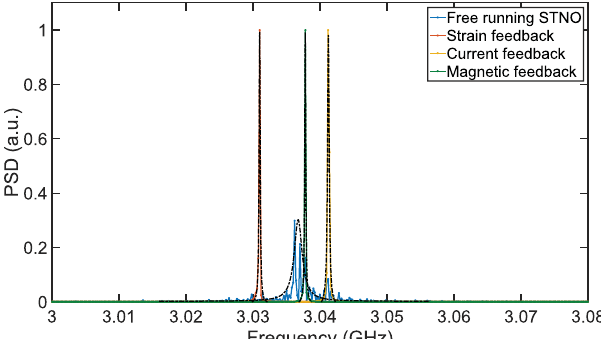
Figure 6. Simulated PSD (Power Spectral Density) spectrums of free running STNO and MASH oscillators with different feedback methods. Linewidth and Q of the oscillators are extracted by fitting a Lorentzian function to PSD spectrums. MASH oscillators exhibit a 15X enhancement in the linewidth compared to the free running STNO, exceeding Q of 10000 with all feedback methods. PSD spectrums of MASH oscillators are intentionally shifted for a clear comparison. PSD spectrum clearly shows that there are no side peaks caused by the other resonance peaks of the HBAR.